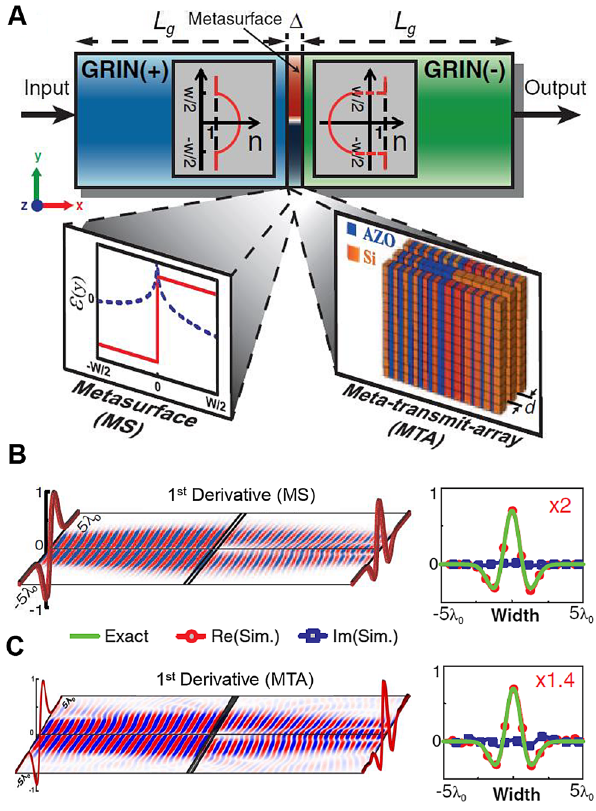
Figure 2: Metamaterials for spatial analog computing [34]. (A) Cascaded properly designed GRIN( + )/metastructure/GRIN( − ) system to perform mathematical operations in the spatial Fourier domain. Two designs are proposed for the middle metastructure including (i) a speci fi c-purpose thin ( Δ = λ 0 /3) single-layer